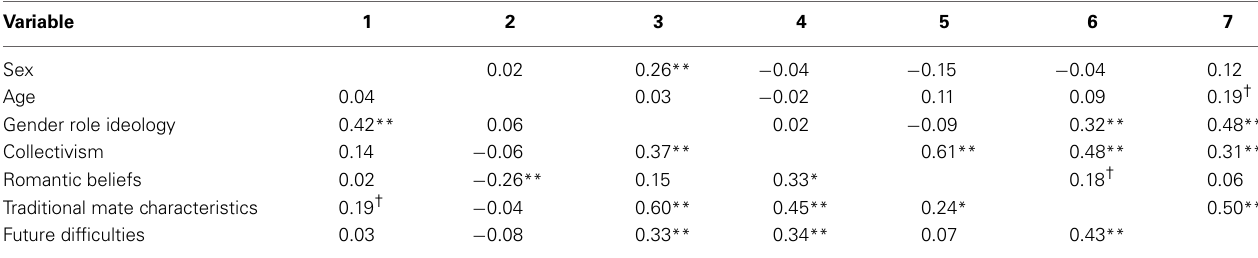
Table 2 | Pearson’s correlations for Indians and Americans.